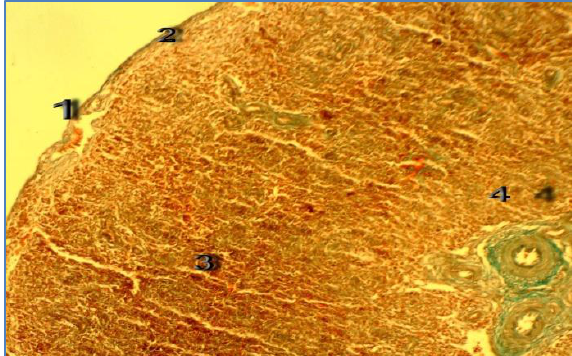
Figure, 3: At 1 day after hatching showing 1.Capsule, 2.Sub-capsular tissue, 3.Red pulp and 4.White pulp, Masson Trichrome x100.